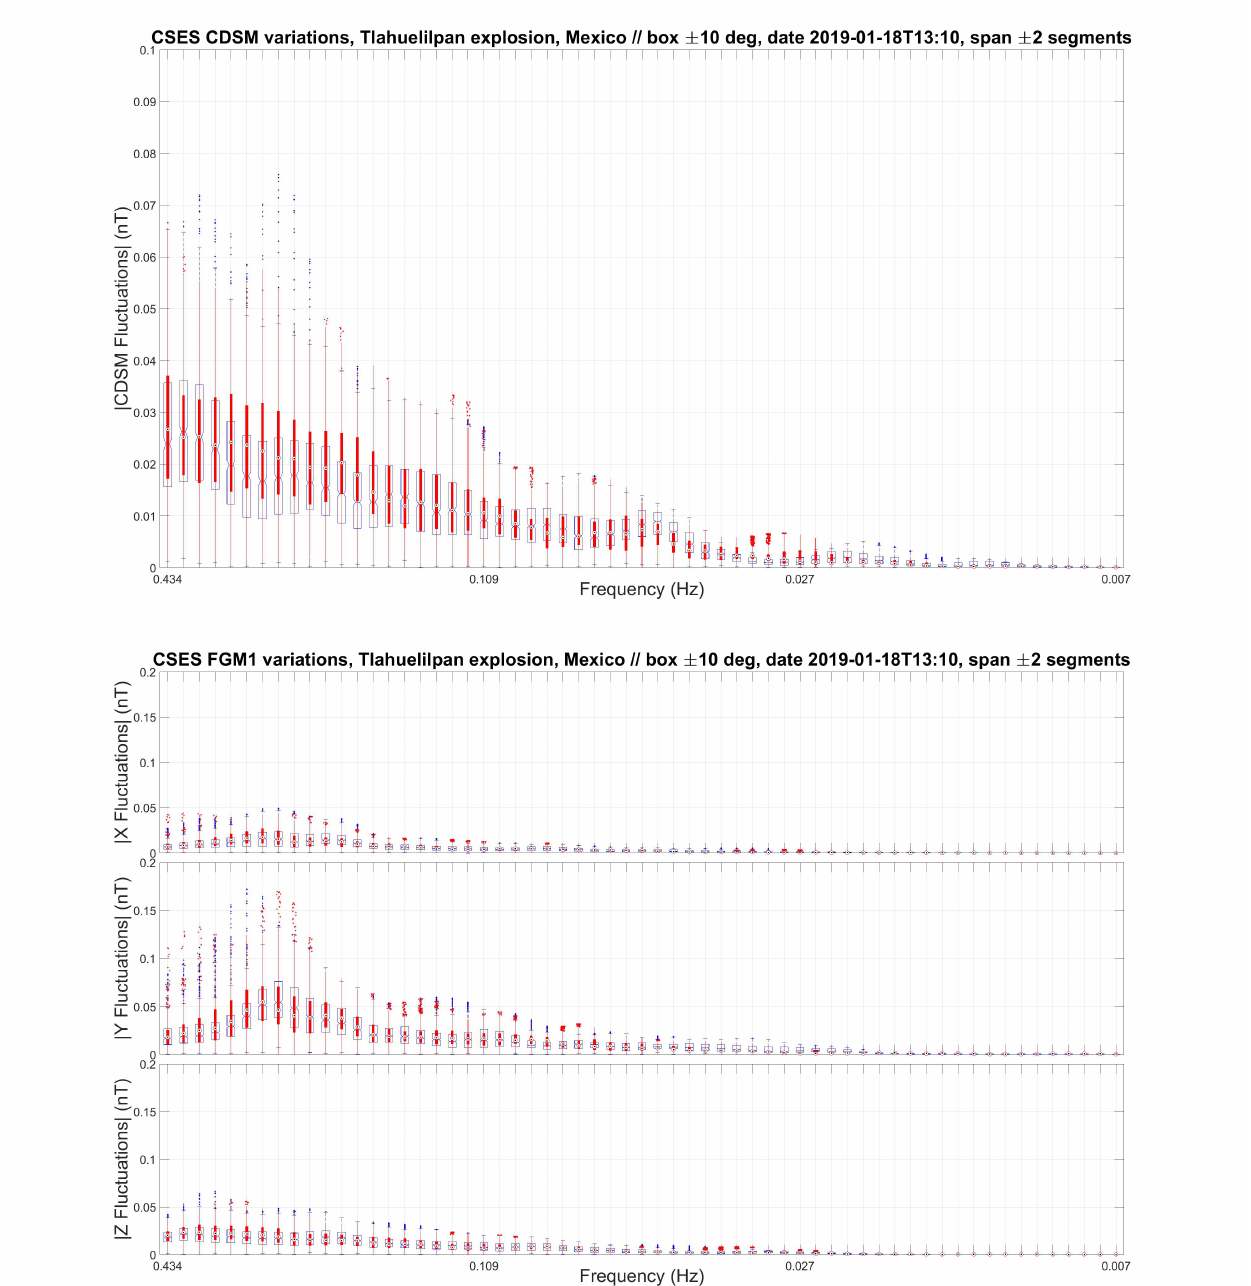
Figure 8. Distribution of CSES CDSM ( top ) and FGM1 ( bottom ) magnetic field fluctuations grouped in individual frequency bands for the Tlahuelilpan, Mexico, event, 2019-01-18T13:10 UTC. The time shift to the event is ∆ t = { − 1.21, − 0.66, − 0.22, 0.33, 0.83} days. The colour coding is the same as in Figure 2, the geomagnetic activity is | Dst | ≤ 15 nT for the selected time